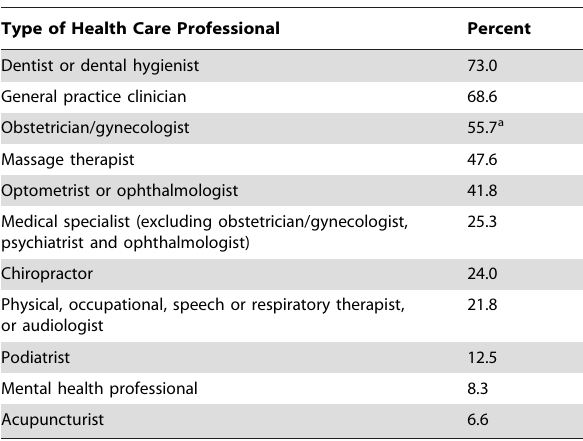
Table 4. Percentage of 1,212 active ultramarathon runners reporting to have visited various types of health care professionals in the prior 12 months.